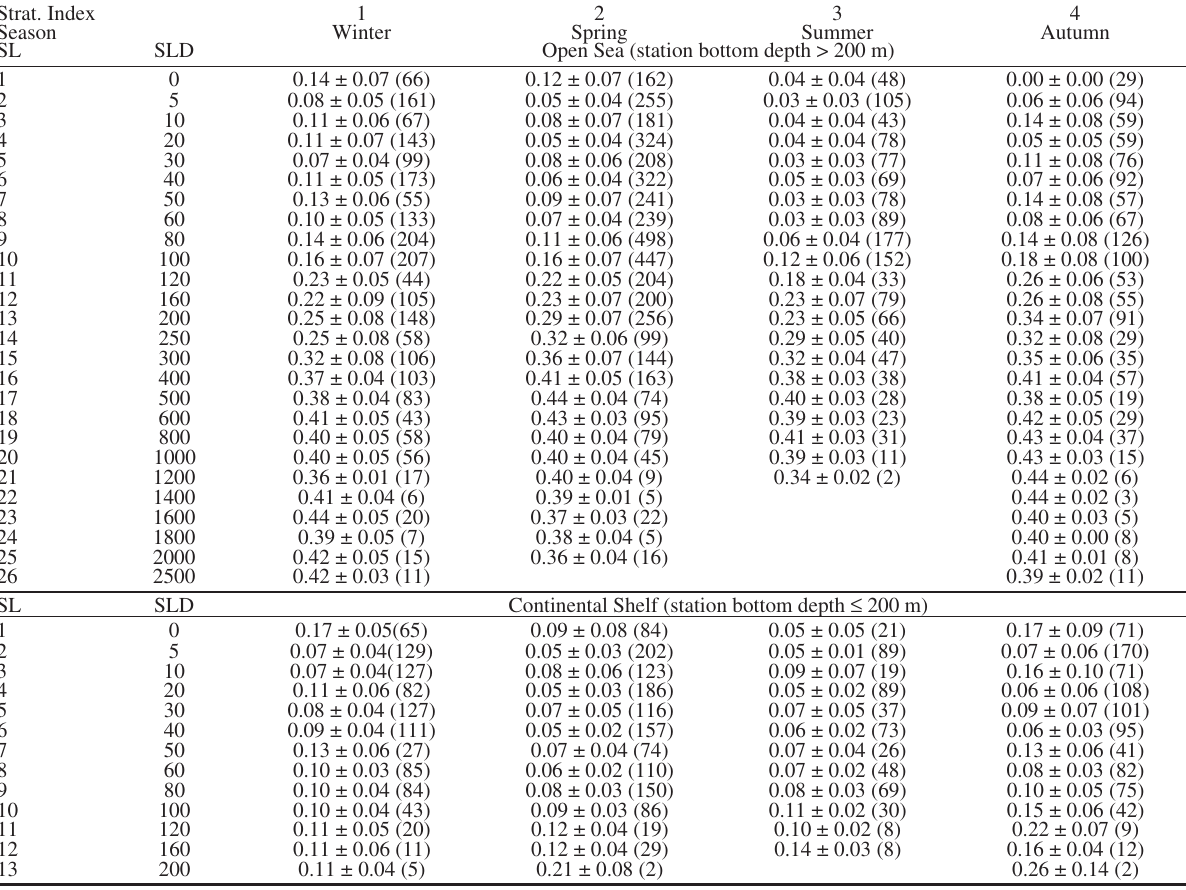
Table S2. – Phosphate concentration (μM) with depth and stratification of the water column in the Catalan Sea (NW Mediterranean Sea). Shown are median ± median absolute deviation (number of data between parentheses). SL, Standard Level; SLD, Standard Level Depth (m). Strat. Index